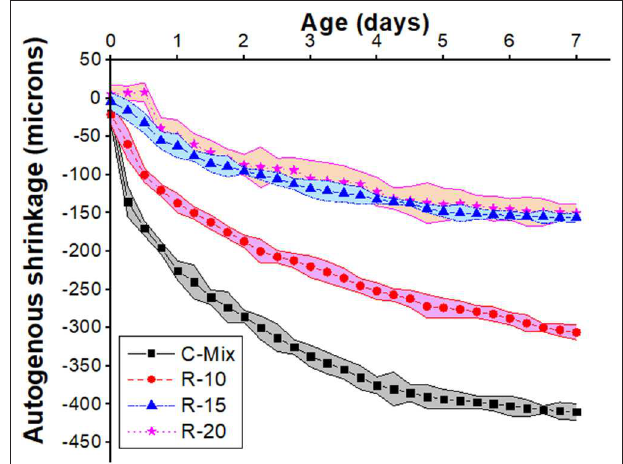
FIGURE 9 | Comparison of autogenous shrinkage of concretes containing RHA with control concrete.